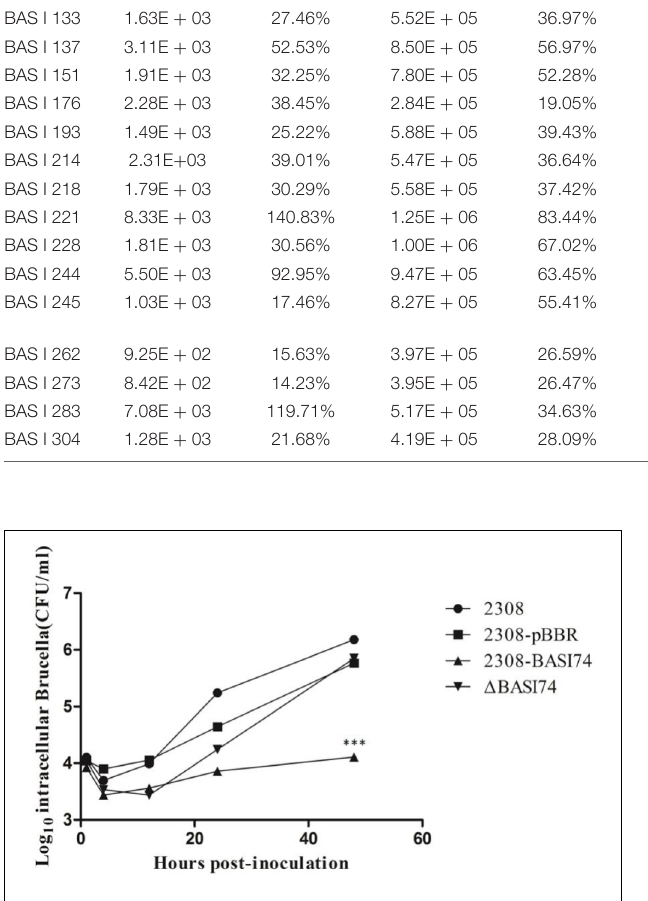
FIGURE 2 | Effect of BASI74 on Brucella virulence in macrophage infection model. Multiplication of B. abortus 2308, 2308-BASI74, (cid:49) BASI74, and 2308-pBBR1 in J774A.1 macrophages over 48 h. Values represent the means of three independent experiments performed in duplicate, and error bars indicate the SD. ∗∗∗ indicated the p <